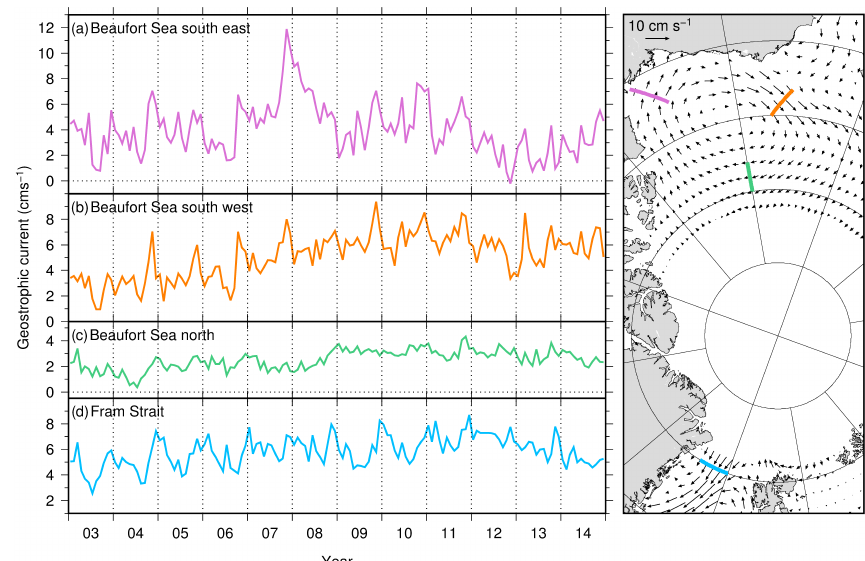
Figure 4. The geostrophic current speed normal to various gates in the Arctic Ocean: the colour of the time series corresponds to the colour of the gate on the map (right panel). The time series, from top to bottom, are the current speed through the southeastern (positive southwest), southwestern (positive northwest) and northern (positive east) gates in the Beaufort Sea and the Fram Strait gate (positive south). The 2003–2014 mean geostrophic velocity vectors are shown on the map. The y axis has been scaled such that the vertical increment is constant.